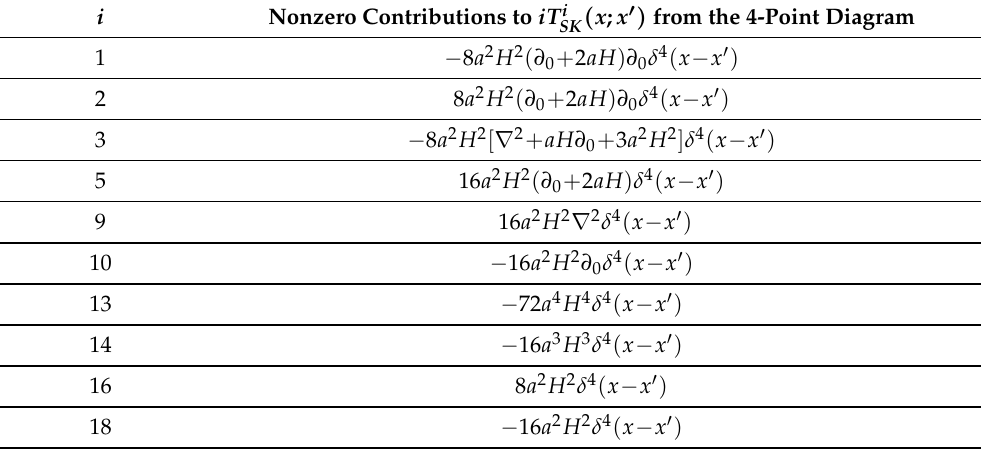
Table 9. Each of the tabulated terms must be multiplied by κ i Nonzero Contributions to iT i